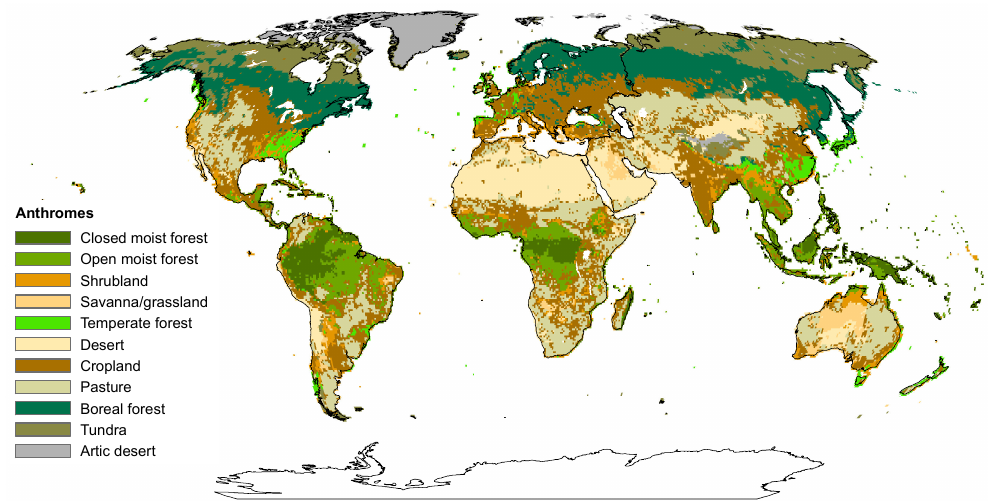
Figure 2. Global anthrome classes in the potential natural vegetation and agricultural areas. Anthrome classes are defined using coverage with types of dominating natural vegetation (e.g. tropical forest), dominant agricultural usage (e.g. cropland), and external drivers (e.g.